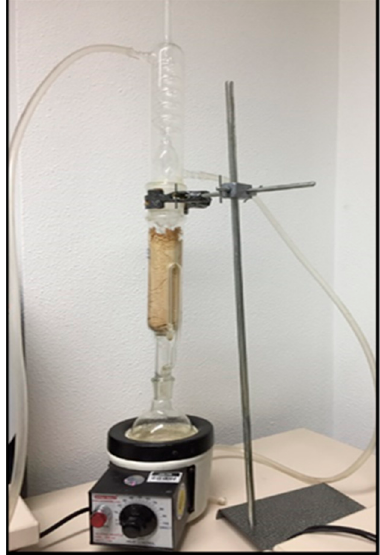
Figure 1. Plant extraction using alcohol in a Soxhlet extractor.